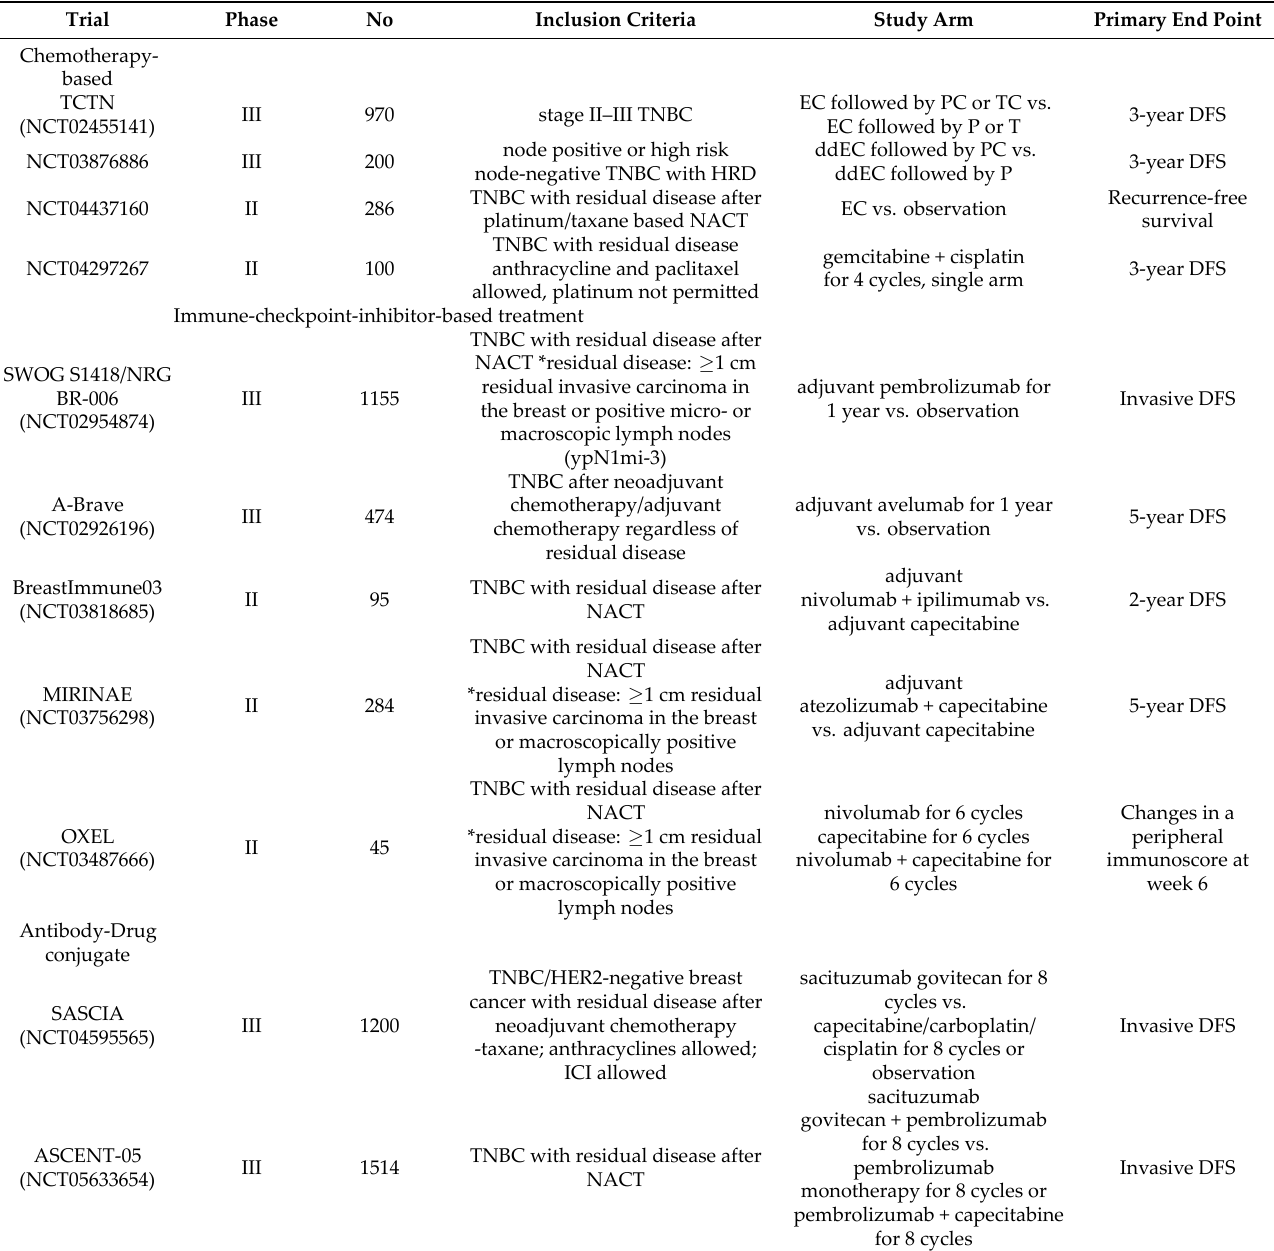
Table 2. Summary of ongoing trials in patients with residual disease after neoadjuvant